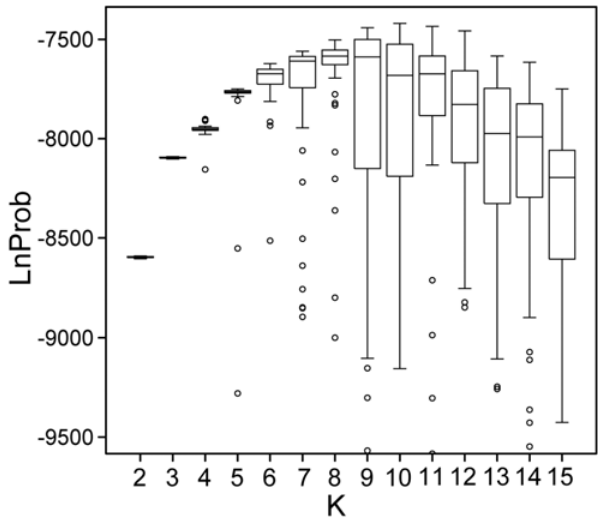
Figure 2. Distribution of likelihood scores for 50 independent runs of STRUCTURE at each value of K from 2 to 15.